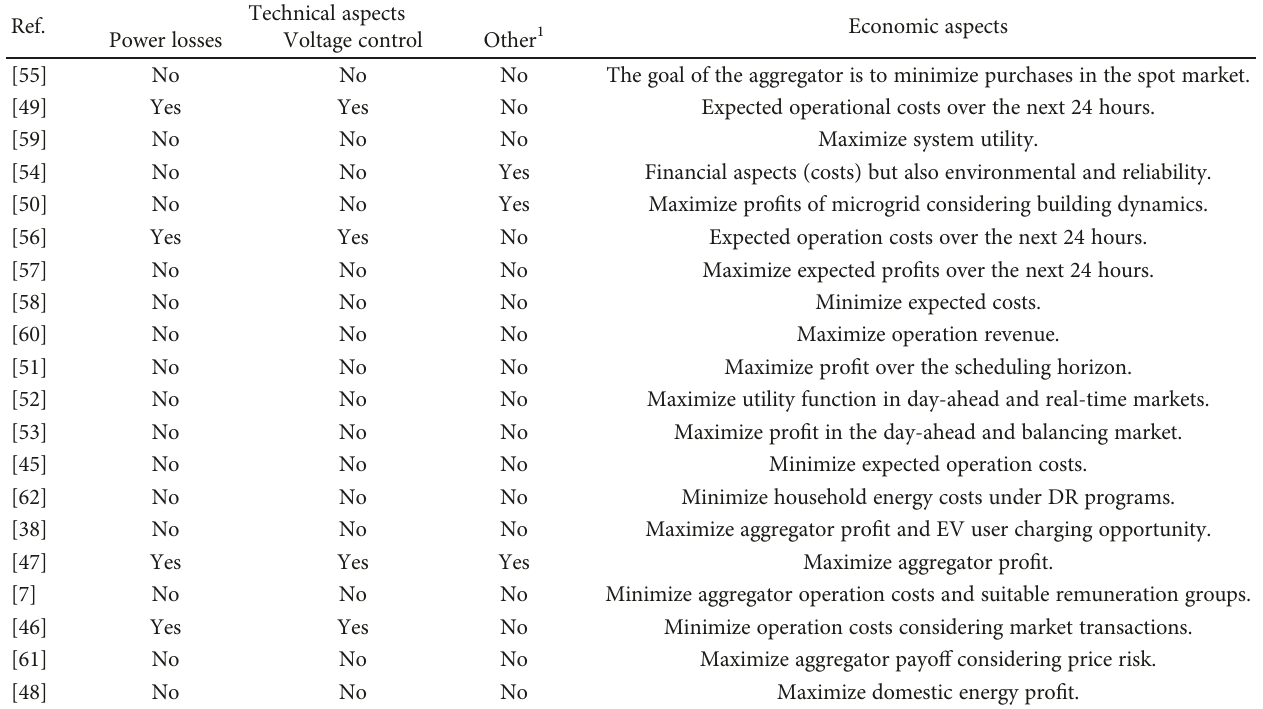
Table 3: Summary of energy scheduling models: technical and economic aspects.